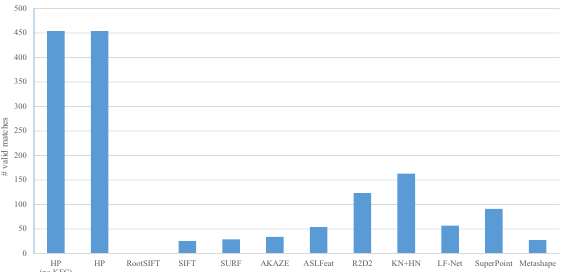
Figure 8. Number of valid RANSAC/DegenSAC matches for the nadiral-oblique image pair with the largest overlap in the Ven- timiglia Theatre Nadiral+Oblique